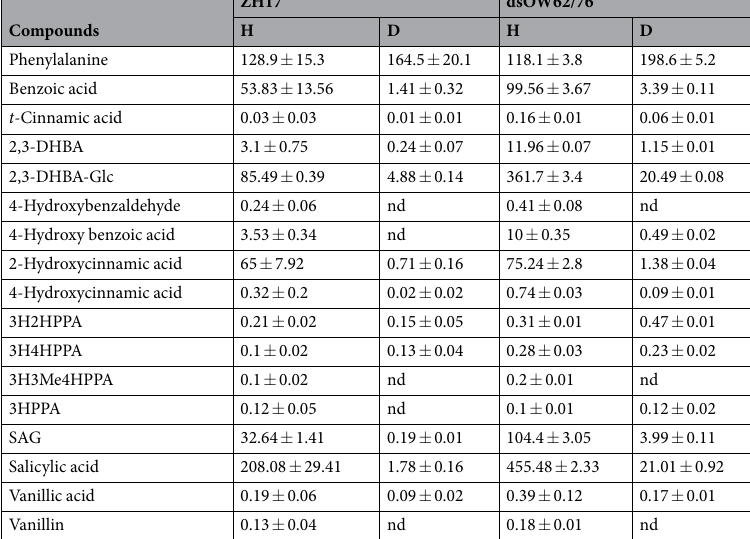
were increased (Fig. 2B; Supplementary Fig. S2). The peroxisome localized acyl-activating enzymes of At4g19010 and At1g20510 are required for ubiquinone and jasmonate biosynthesis in Arabidopsis, respectively 31, 32 . The data implied the existence of potential differences in the requirement of ubiquinone and jasmonate between dsOW62/76 and ZH17 plants. To efficiently annotate the metabolites of the phenylpropanoid pathway, we used [ 2 H 8 ]Phe to track the bio- synthetic flux. The isotope labeled compounds are shown in Fig. 2A and Table 1 and their MS/MS ions are shown in Supplementary Table S7. Samples were collected at 12 h (early) and 48 h (late) post feeding treatment of dsOW62/76 and ZH17 plants with [ 2 H 8 ]Phe. The detection of deuterium labeled SA and its derivatives such as SA glucoside (SAG) and 2,3-dihydroxybenzoic acid (2,3-DHBA) confirmed that phenylpropanoid pathway mediates the biosynthesis of SA via BA 33 and indicated the existence of multiple ways to maintain SA home- ostasis. In petunia, PhCHD (cinnamoyl-CoA hydratase-dehydrogenase) is characterized to efficiently convert cinnamoyl-CoA (Cin-CoA) to 3-oxo-3-phenylpropionoyl-CoA (3O3PP-CoA), which is the substrate for the final step in the BA β -oxidation pathway 30 . Consistent with these observations, qRT-PCR results showed that transcription of LOC_Os02g17390 ( OsCHD ) gene, the closest homolog of PhCHD (Supplementary Fig. S2), was upregulated in dsOW62/76 plants (Fig. 2B). Also, OsKAT1 (3-ketoacyl-CoA thiolase 1) homologous to PhKAT , catalyzing the formation of benzoyl-CoA (Ben-CoA) from 3O3PP-CoA, was strongly induced in dsOW62/76 (Fig. 2B; Supplementary Fig. S2; Supplementary Table S6). These data may reflect a higher rate of biosynthesis SA from t -CA in dsOW62/76 than ZH17 plants as observed in the isotope chasing experiments. In the case of 4HBA formation, we observed deuterated 3-hydroxy-3-(4-hydroxyphenyl) propionic acid, 4HBAld and 4HBA (Fig. 2A; Table 1), suggesting that the non-oxidative routes also participated in the 4HBA biosynthesis. Recently, it has been reported that vanillin and its glucoside are synthesized by a single enzyme, vanillin synthase, through the two-carbon cleavage of ferulic acid and its glucoside in vanilla pods in a cou- pled non-oxidative hydratase/lyase reaction 34 . Interestingly, we detected deuterated VA in the early samples from both dsOW62/76 and ZH17 plants (Table 1) but not for deuterated vanillin even at 48 h post feeding treatment, although VA and vanillin pools were at similar levels (Supplementary Table S8). The presence of low levels of 3-hydroxy-(3-methoxy-4-hydroxyphenyl) propionic acid (3H3Me4HPPA) without deuterium labeling implied that vanillin could be synthesized through non-oxidation route at quite a low turnover rate; however, VA might be formed by β -oxidative pathway from feruloyl CoA (Fer-CoA) ester in rice. Down-regulation of flavonoid biosynthetic pathway in dsOW62/76 plants. Naringenin, the com- mon precursor for a large number of downstream flavonoids, is synthesized from coumaroyl-CoA (Cou-CoA) together with three moieties of malonyl-CoA catalyzed sequentially by chalcone synthase (CHS) and chalcone isomerase (CHI). There are two kinds of flavone synthases (FNS) that catalyze the conversion of flavanones to flavones. In rice, CYP93G1 functions as an FNSI that converts flavanone naringenin and eriodictyol directly to flavone apigenin and luteolin, respectively, and that they can convert to flavone O -glycosides 35 . The biosynthetic